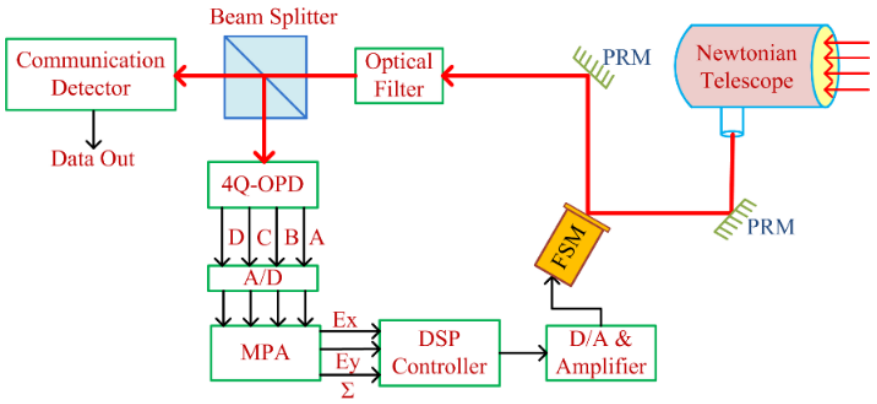
Figure 6. Schematic of a PAT system in FSO communication.